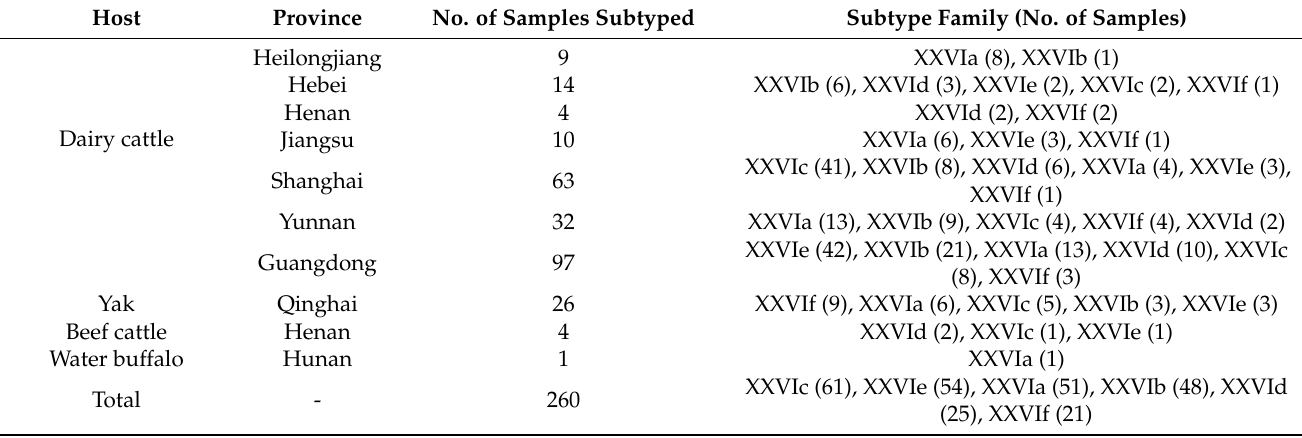
Table 4. Distribution of Cryptosporidium bovis subtype families at the gp60 locus by location in China.